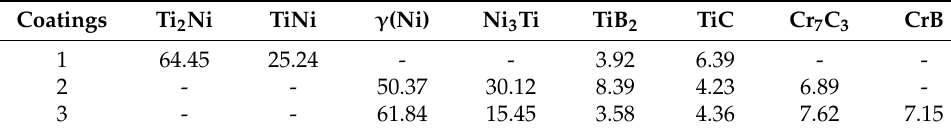
Table 1. The volume fractions of different phases in the coatings